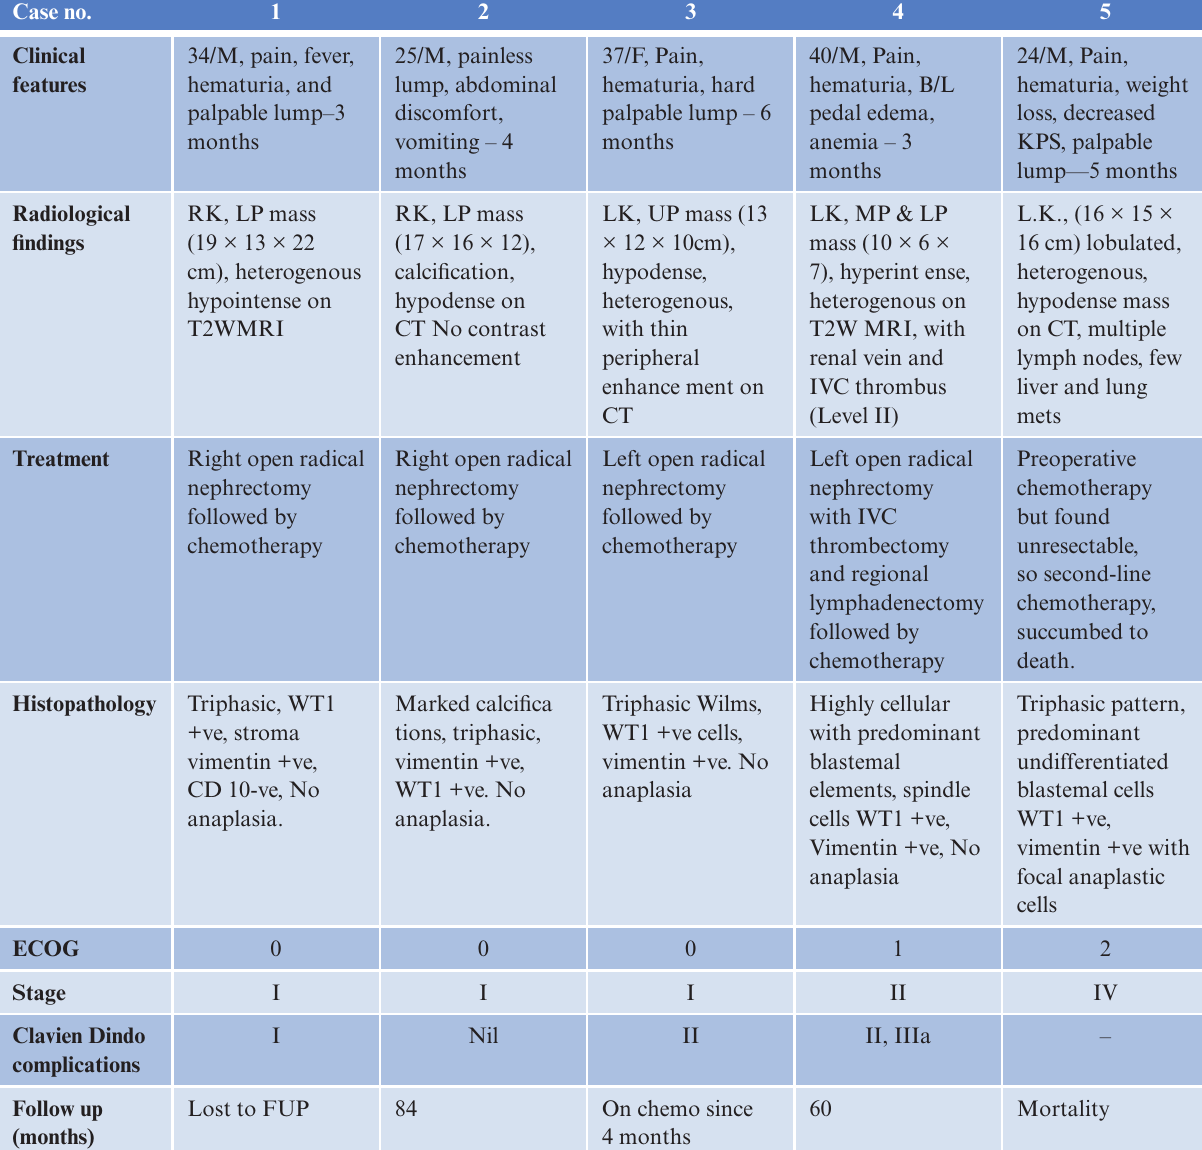
Table 1: Showing the clinical, radiological, therapeutic, and histopathological details of the cases included in our study. Case